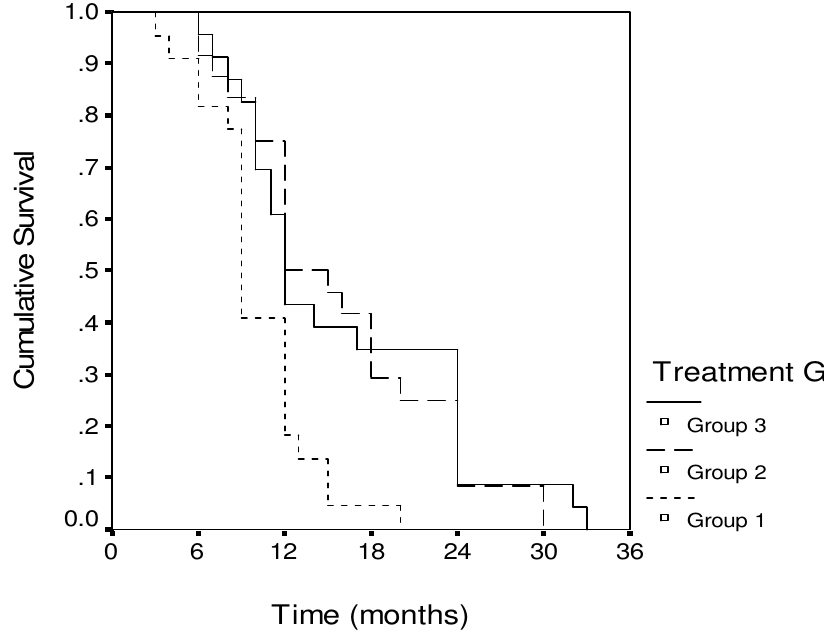
FIGURE 7. Kaplan-Meier survival curve of the patients in three treatment groups with respect to